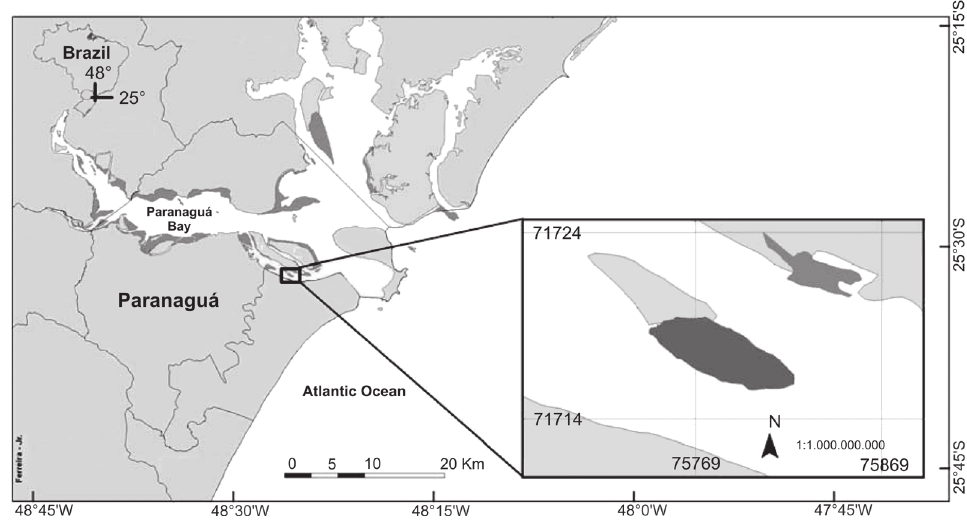
Figure 1. Paranaguá estuarine complex and sub-estuarine sector of Cotinga, where the study site the Papagaios tidal flat is located (dark gray